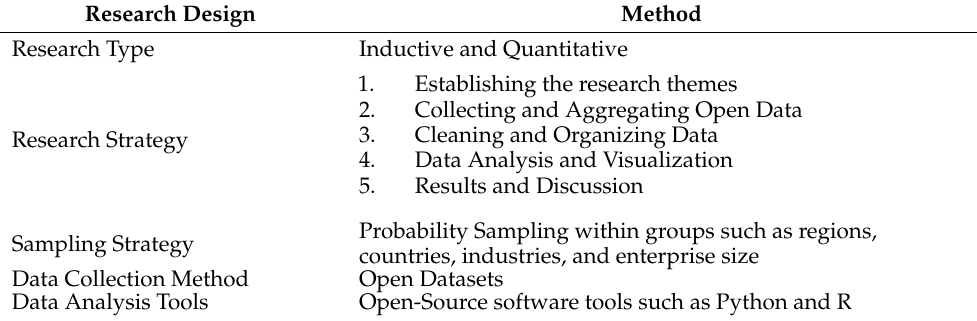
Table 1. Research